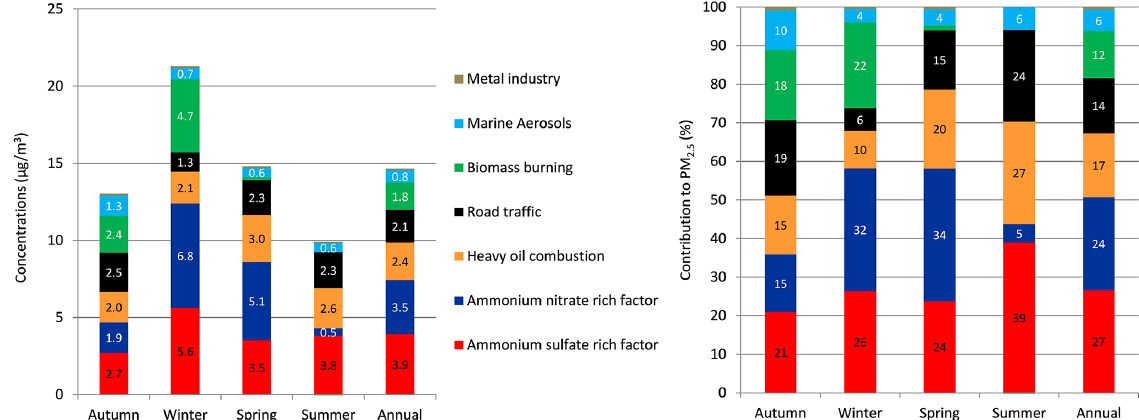
Figure 9. Averaged seasonal and annual contributions in µgm − 3 (left) and in % (right) of the seven sources to PM 2 . 5 mass (14.7µgm − 3 ). Note that contributions below 0.2µgm − 3 (left) and 1% of PM 2 . 5 mass (right) are not indicated. Calendar seasons were used. Cf. Table 3 for additional